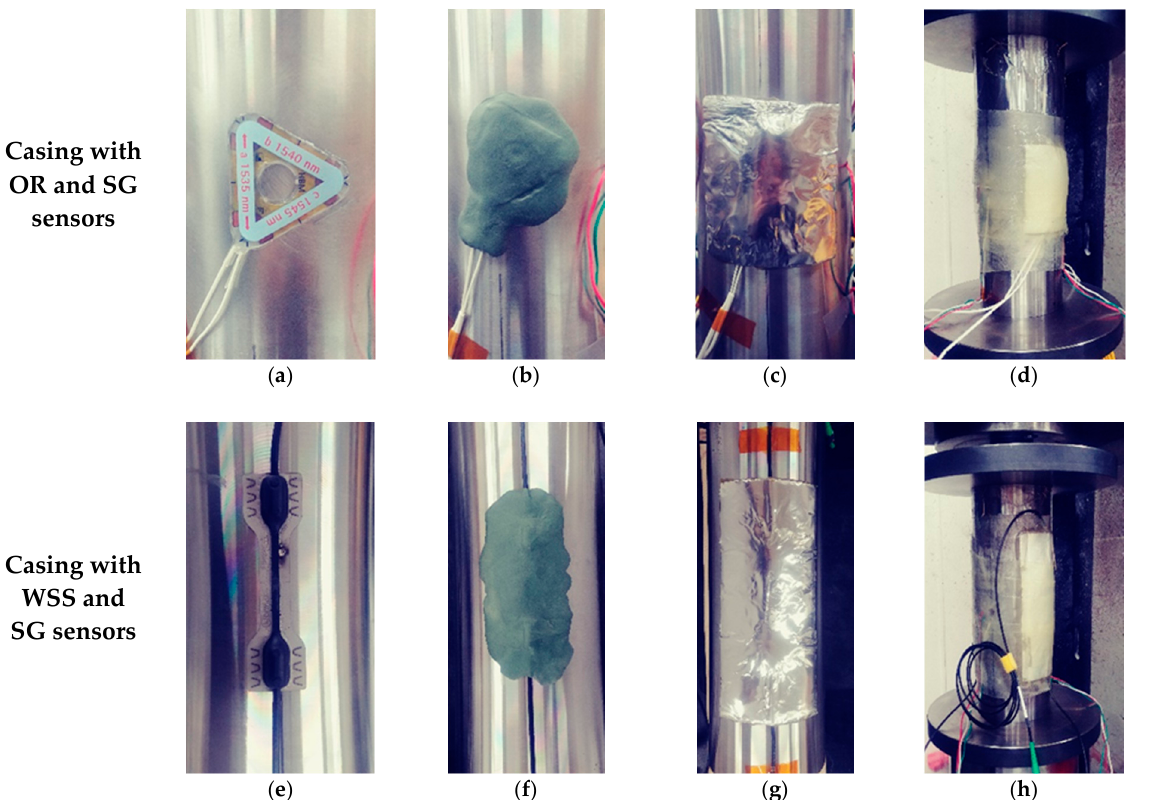
Figure 4. OR sensor and WSS mounting and protection steps: ( a ) OR sensor adhesion; ( b ) OR sensor with AK22; ( c ) OR sensor with ABM75; ( d ) OR sensor with FRP; ( e ) WSS adhesion; ( f ) WSS with AK22; ( g ) WSS with ABM75; ( h ) WSS with FRP.